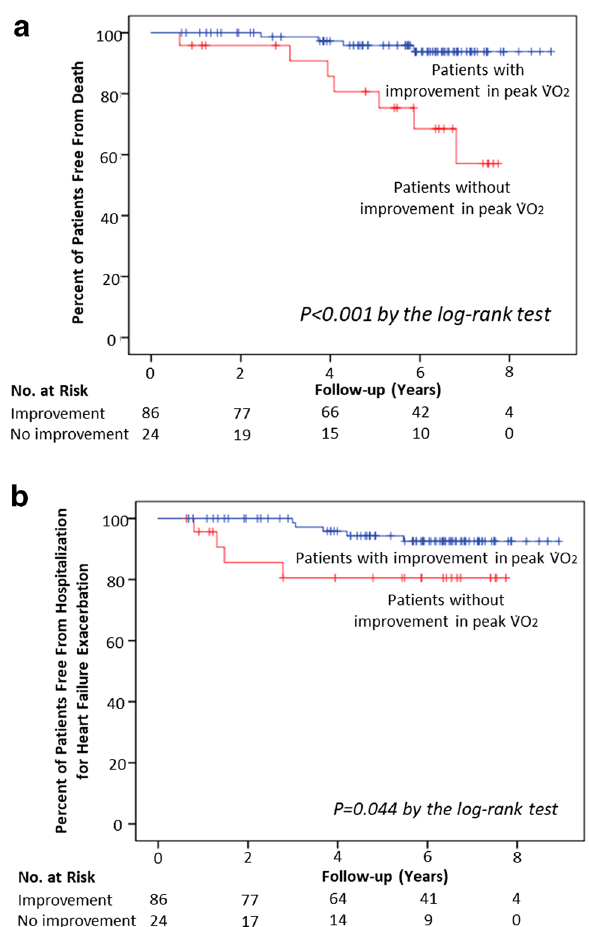
Figure 1. Mortality ( a ) and hospitalization due to heart failure exacerbation ( b ) over time. The Kaplan–Meier estimates of mortality and hospitalization for HF exacerbation over a median follow-up of 6 years are shown for high-risk patients with improvement in peak V ̇ O 2 , high-risk patients without improvement in peak V ̇ O 2 , and patients with a preserved V ̇ O 2 . Tick marks indicate censored data. HF, heart failure; V ̇ O 2 , peak exercise oxygen